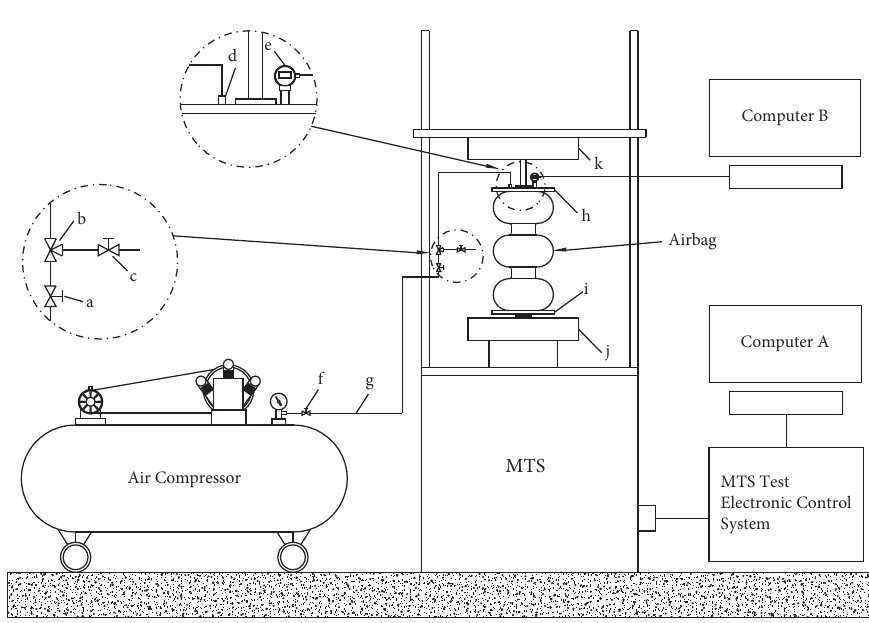
Figure 3: Tension and compression test principle of the airbag: (a) intake valve, (b) three-way valve, (c) vent valve, (d) intake port, (e) intelligent pressure transmitter, (f) intake switch, (g) intake pipe, (h) upper flange, (i) lower flange, (j) actuator, and (k) load-dis- placement